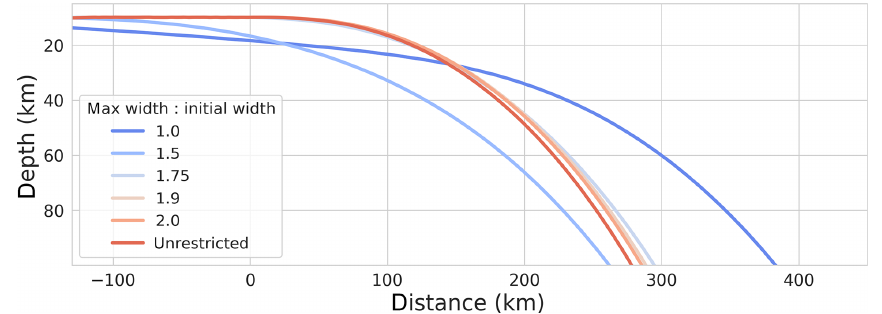
Figure 10. Embedded fault models (EF) with variable W max . Lines show the morphology of the base of the subduction interface (the EF reference line) at 10Myr for different models with varying W max . When the interface thickness variation is strongly constrained, the evolution of the model is significantly effected. See also Fig. 6.